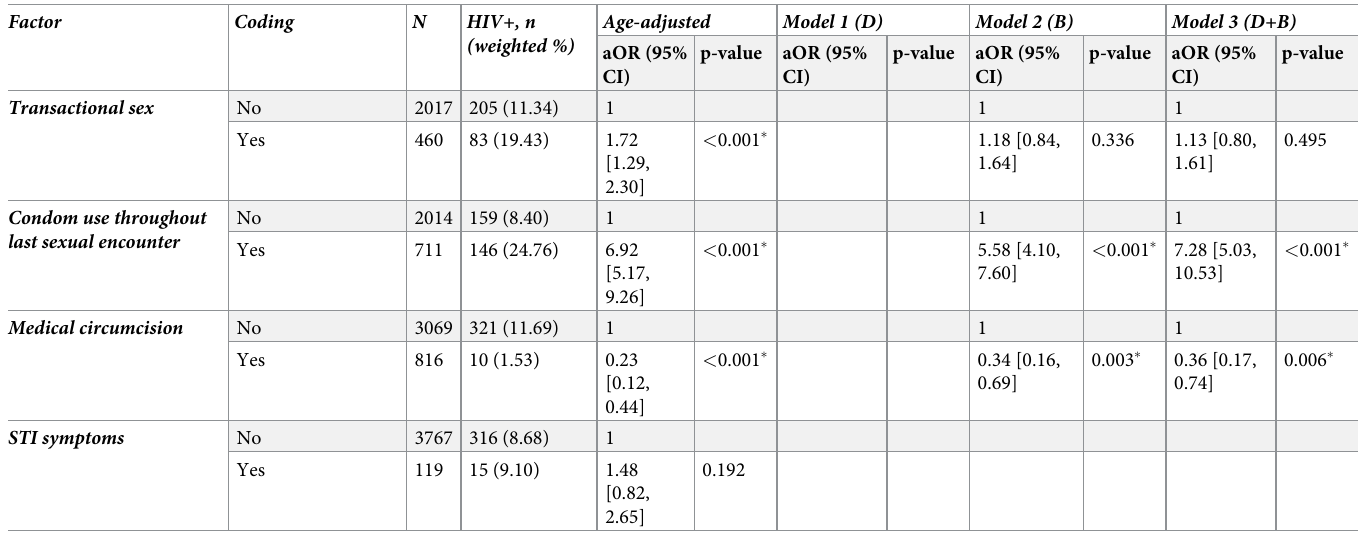
odds with increasing age (relative to 15-24s) and in currently married and widowed groups (relative to singles), and a lower odds in the Christian group. In females, site-type (higher odds in small towns relative to subsistence farming areas), wealth-status (lower odds in 4 th poorest compared to the poorest group), employment sector (lower odds in students compared to unemployed) and alcohol use were additionally associated, while church denomination was not. Model 2 (B) adjusts each behavioural factor for the others. The individual behavioural fac- tors associated with HIV positivity in males were: a higher odds with increasing number of regular sexual partners (lifetime), non-regular partners and condom use, and lower odds with medical circumcision. In females, early sexual debut, a higher number of regular sexual part- ners (lifetime), condom use and concomitant STIs were associated with higher odds of infection. Model 3 (D+B) adjusts for socio-demographic and behavioural covariates to assess whether behavioural variables explain the associations of HIV infection with socio-demographic vari- ables in line with the theoretical framework. With respect to background/socio-demographic variables in males, the highest odds of infection was in those aged 45–54 (compared to 15-24s) (aOR = 34.11; 95% CI 12.06–96.44, p < 0.001), those who were widowed (relative to single) (aOR = 20.96; 95% CI 5.79–75.8, p < 0.001) and don’t belong to a church (aOR = 1.76; 95% CI 1.18–2.63, p = 0.006). In females, the highest odds of HIV was in those aged 35–44 (relative to 15-24s) (aOR = 6.58; 95% CI 4.34–9.97, p < 0.001), living in small towns (relative to subsistence farming areas) (aOR = 1.57; 95% CI 1.09–2.26, p = 0.016), and those who were widowed (rela- tive to singles) (aOR = 4.13; 95% CI 2.32–7.37, p < 0.001). The proximate/behavioural factors in males associated with the highest odds of infection were having 5+ regular sexual partners (relative to 1 sexual partner) (aOR = 2.26; 95% CI 1.45–3.50, p < 0.001), any non-regular part- ners in a lifetime (aOR = 1.42; 95% 1.01–2.01, p = 0.044) and condom use (aOR = 7.28;